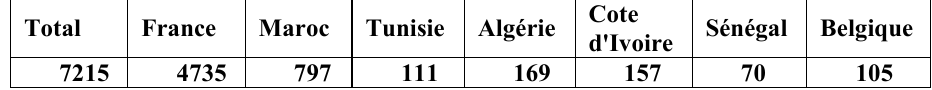
Tableau 9. Nombres d’inscrits selon les